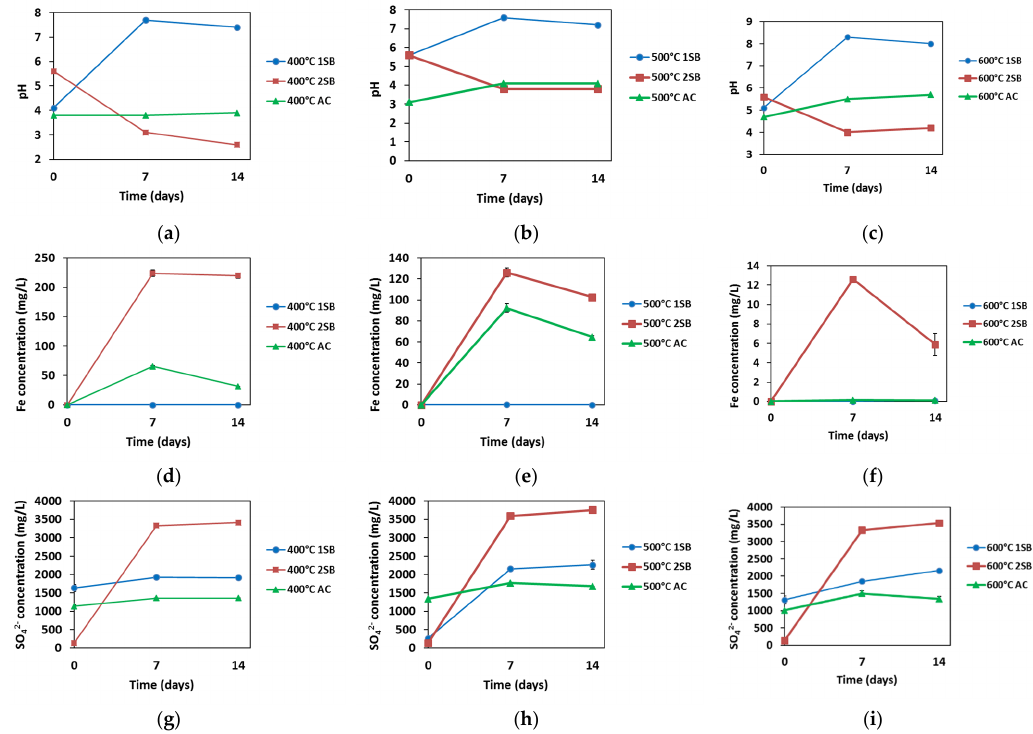
Figure A3. The evolution of pH ( a – c ), Fe ( d – f ) and SO 4 2 − ( g – i ) concentrations during the bioleaching of the microwave ‐ roasted (at 400, 500 and 600°C) Neves Corvo waste rock (NC_01) by T. electrotropha